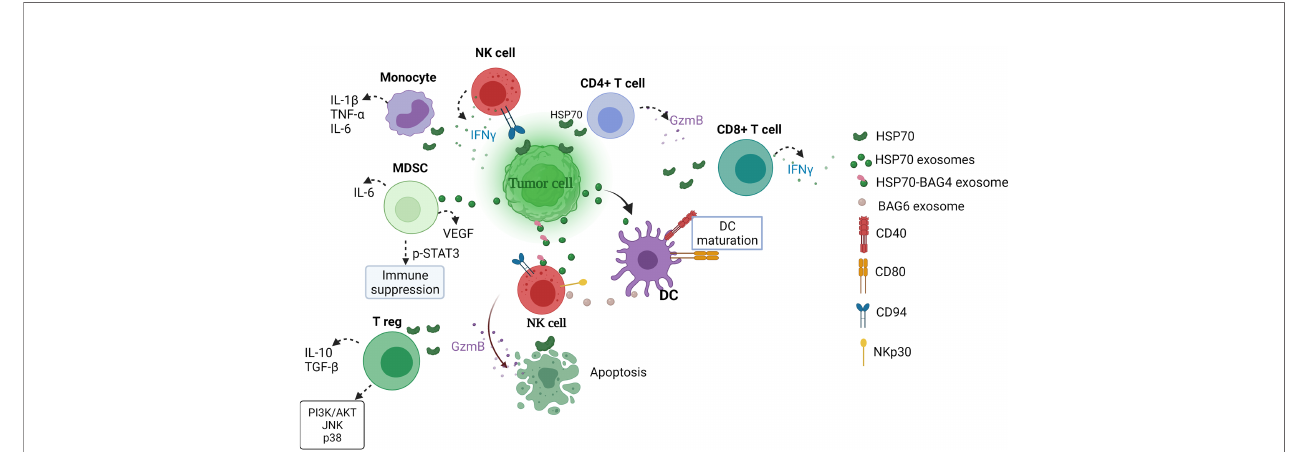
FIGURE 1 | Extracellular HSP70 immune network in cancer. eHSP70s enhance NK cytotoxicity, DC maturation, induce strong CD4+ and CD8+ T cell responses and cytokine secretion by monocytes and enhance immunosuppressive activity of MDSCs and T regs (54, 112 – 118). MDSCs, myeloid-derived suppressor cells; T reg, T regulatory cell; GzmB, granzyme B; DC, dendritic cells; IFN g , interferon g ; BAG, BCL2-associated athanogene; IL-6, interleukin-6; TNF- a , tumor necrosis factor a ; VEGF, vascular endothelial growth factor; TGF- b , transforming growth factor b ; PI3K/AKT, phosphatidylinositol 3-kinase (PI3K)-serine/threonine protein kinase (AKT), JNK, c-Jun N-terminal kinase; STAT3, signal transducer and activator of